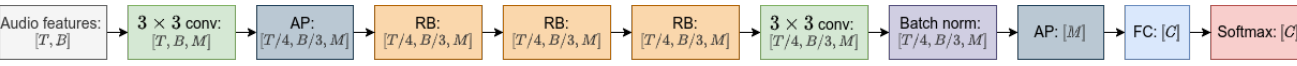
Figure 4. The scheme of the res8 neural network used in our experiments. The shape of the resulting tensor is specified after each block in square brackets. FC stands for the fully-connected layer, AP stands for the average pooling layer, RB stands for residual block (Figure 3). T is the number of frames in a sample (98 in all our experiments). B is the number of channels in the audio features (80 for log-mel filterbanks, 512 for wav2vec features). C is the number of classes to discriminate. M is the number of feature maps (45 for res8 ).